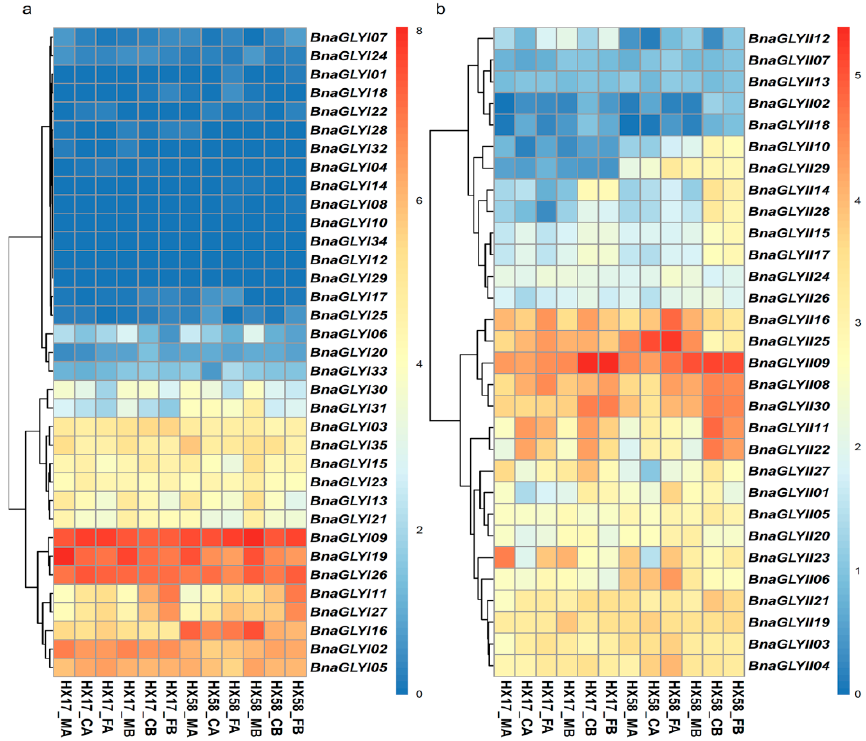
Figure 8. Expression of BnaGLY genes under different low-temperature treatments. ( a ) BnaGLYI genes; ( b ) BnaGLYI genes. The expression levels of each gene (log 2 (FPKM values + 1)) in each sample is indicated by different color rectangles. The transcripts of each gene in leaves treated with chilling and freezing, with or without cold acclimation, were determined using the data from GEO (GSE129220). HX17 and HX58 were two early maturing semi-winter rapeseed varieties. This shows the expression level of BnGLY genes in the two B. napus varieties with different cold tolerances under cold accumulations at chilling (CA) and freezing (FA) temperature and cold shocks at the same temperature (CB and FB) condition. MA and MB were the control with and without cold accumulations, respectively.